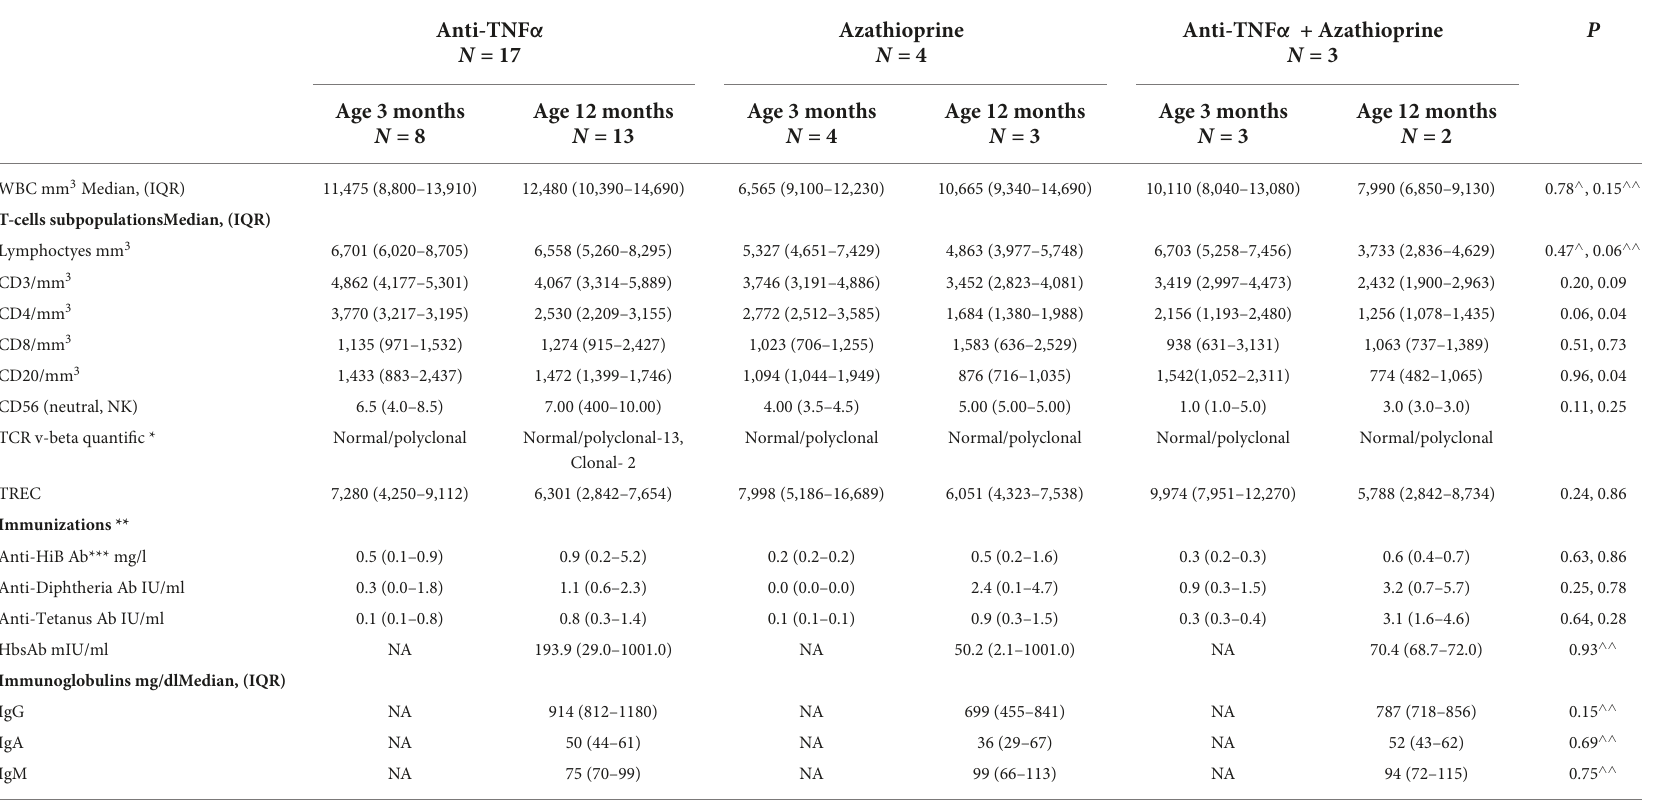
TABLE 5 B-cell and T-cell function of the newborns exposed to anti-TNF α , Azathioprine and combination